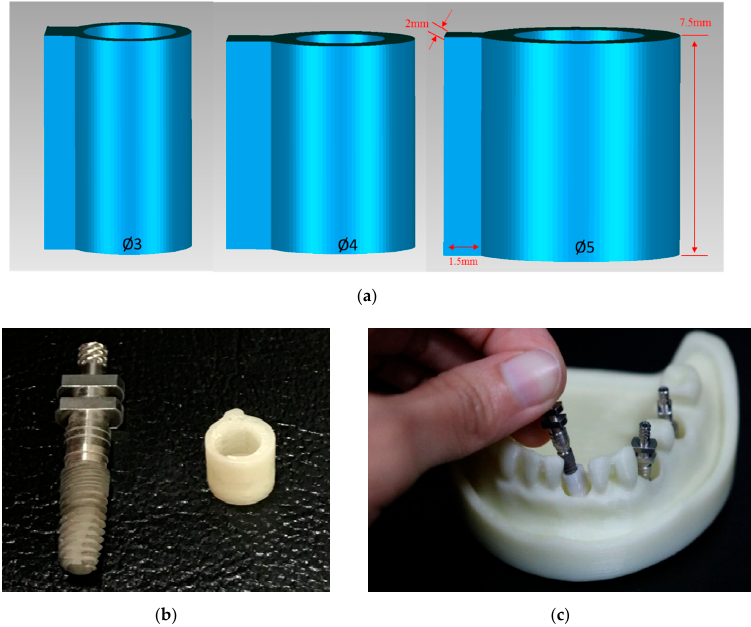
Figure 2. ( a ) Three-dimensional (3D) CAD model of suites for incisor, first premolar, and first molar positions. ( b ) One implant with mapping suite set. ( c ) Transfer of the implant and mapping suite set to the ABS peri-implantitis